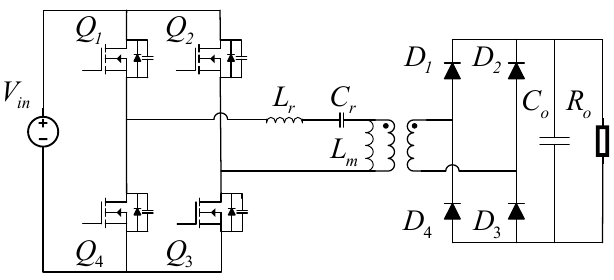
Figure 1. Conventional isolated LLC resonant converter.